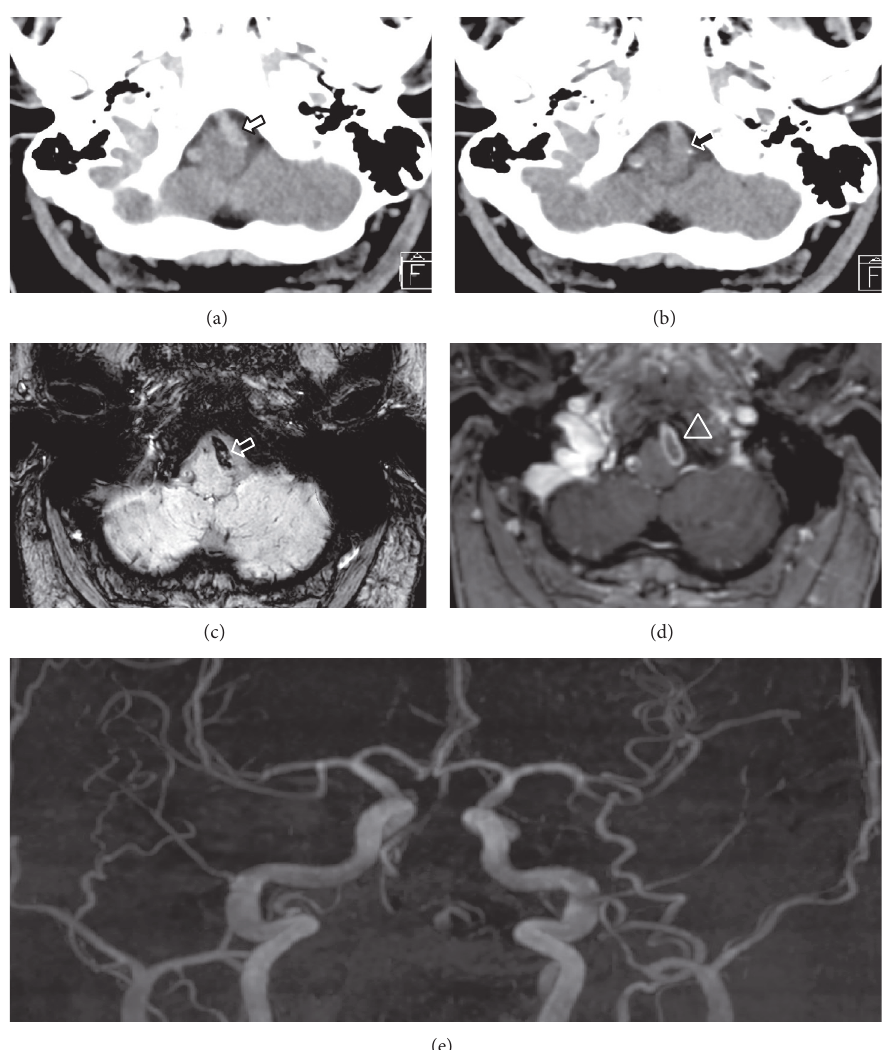
Figure 1: Seven months before presentation left VA is patent with intraluminal average Hounsfield units (aHU) of 60.6 on native CT (open black arrow) (a). 23 hours after symptom onset. Black arrow shows subtle hypodensity with aHU of 42.4 in the left VA (closed white arrow) (b). Three days after symptom onset susceptibility weighted effect in left VA (empty white arrow) (c) and flow void with rest-flow around clot in contrast-enhanced MR T1 (open white arrowhead) (d). MR time-of-flight angiography showing the absence of flow in both VAs